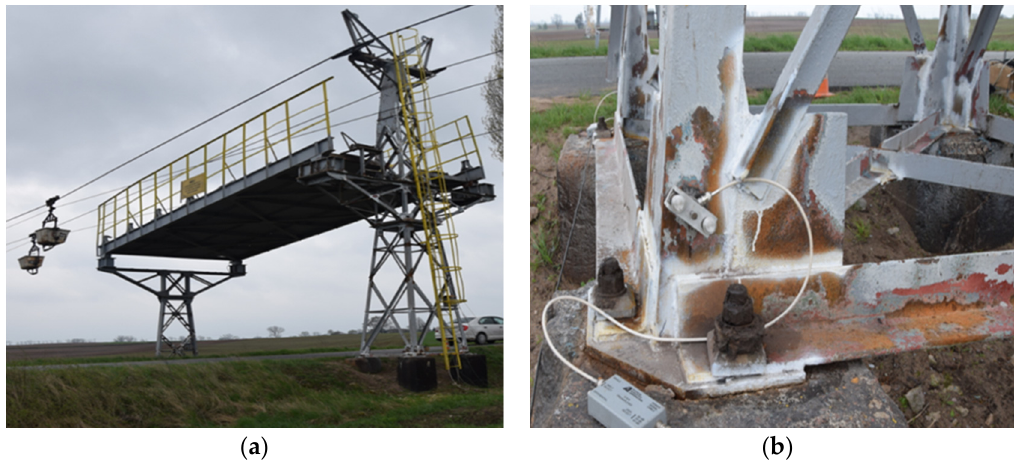
Figure 3. ( a ) View of column 1 with a safety platform. ( b ) View of anchor block and flanges at the connection between column 1 and foundation; signs of surface corrosion and pitting.